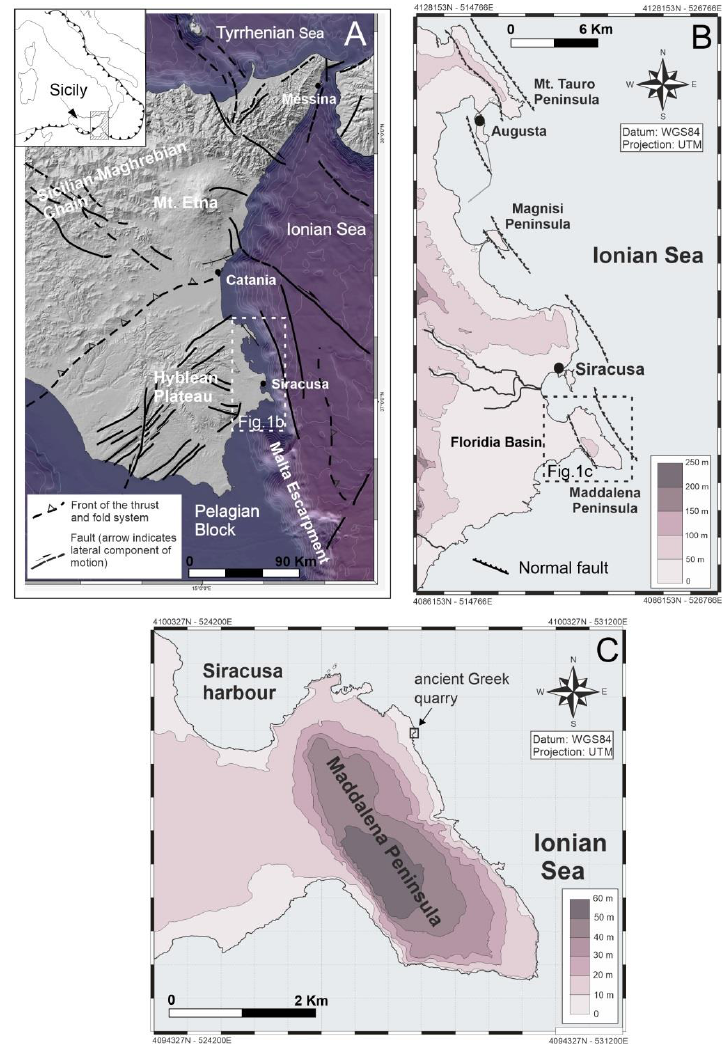
Figure 1. Geological settings of Southeastern Sicily. ( A ) Tectonic sketch map of the Sicilian Collision Zone in eastern Sicily (from Cultrera et al. [39], modified). ( B ) Position of the Maddalena Peninsula area along the Ionian coast of southeastern Sicily. ( C ) Morphological map of the Maddalena Peninsula showing the location of the study area (box).